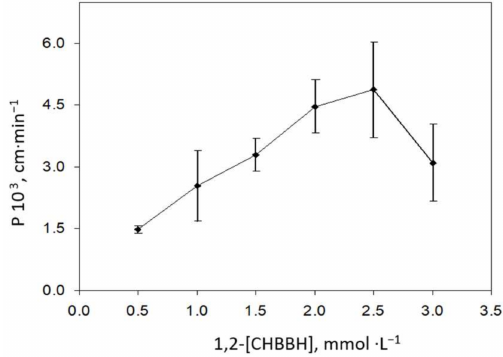
Figure 1. Variation of the permeability coefficient with the 1,2-CHBBH concentration in the organic